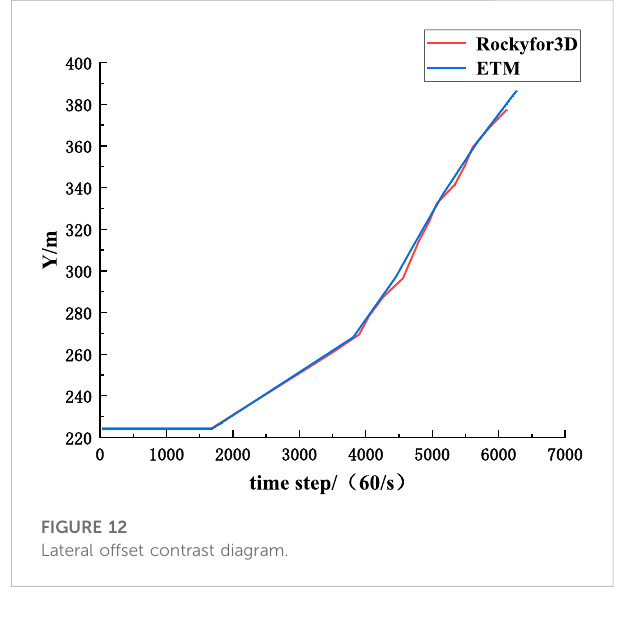
FIGURE 12 Lateral offset contrast diagram.